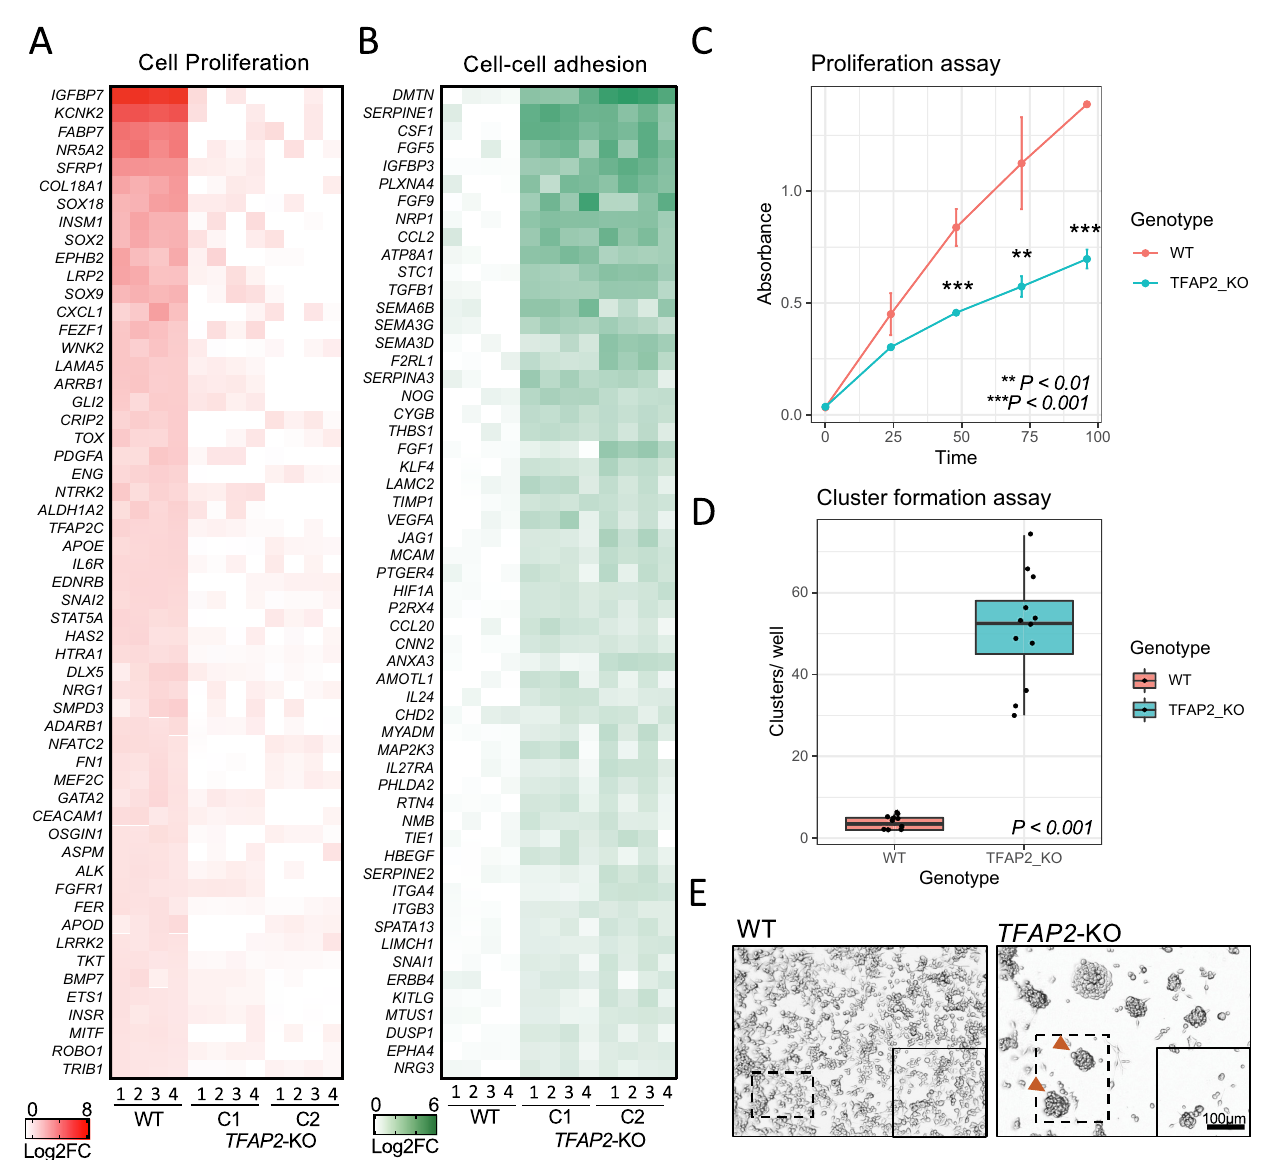
Fig 6. TFAP2 paralogs promote cell proliferation and inhibit cell-cell adhesion a melanoma cell line. ( A ) Heatmap representing the top 55 directly TFAP2-activated genes and ( B ) the top 55 directly TFAP2-inhibited genes that are associated with the GO terms cell pigmentation and cell-cell adhesion, respectively. Four replicate RNA-Seq experiments are shown for WT cells and two clones of TFAP2 -KO cells (Clone 2.12 and Clone 4.3) (FDR < 0.05). ( C ) Growth curves (mean ± SE of mean) over 100 hours of cultivation for WT and TFAP2 -KO SK-MEL-28 cells. x-axis is time and y-axis is absorbance at 450nm which is directly proportional to number of living. ( D ) Box plots representing the quantification of cluster formation on low-bind plates after 72 hours of culture (n = 12 independent experiments, p < 0.001 by Student’s t-test, plot shows mean ± SD). ( E ) Representative images of clusters formed in WT and TFAP2 -KO cells after 72